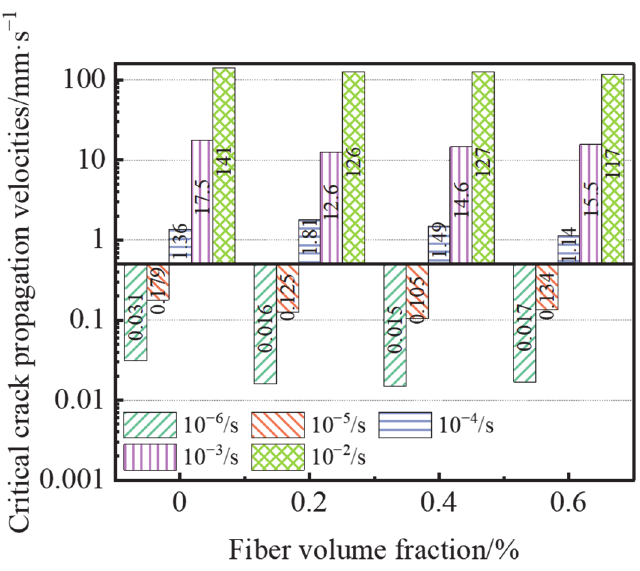
Figure 17. Effect of fiber content on critical crack propagation velocities.